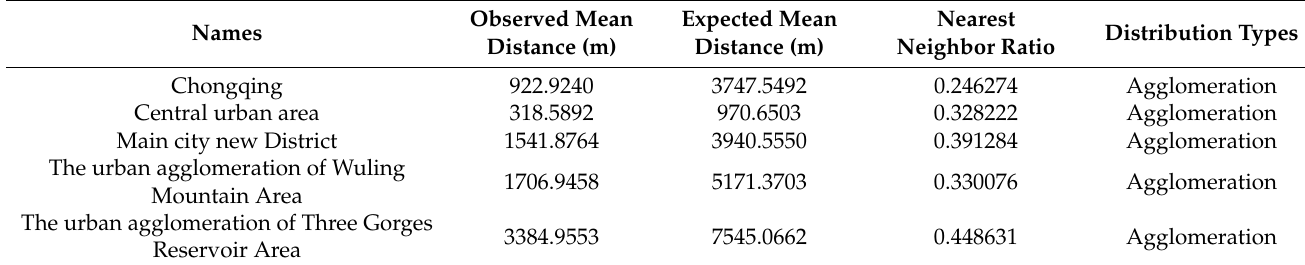
Table 2. Nearest-neighbor index of homestays in Chongqing and its